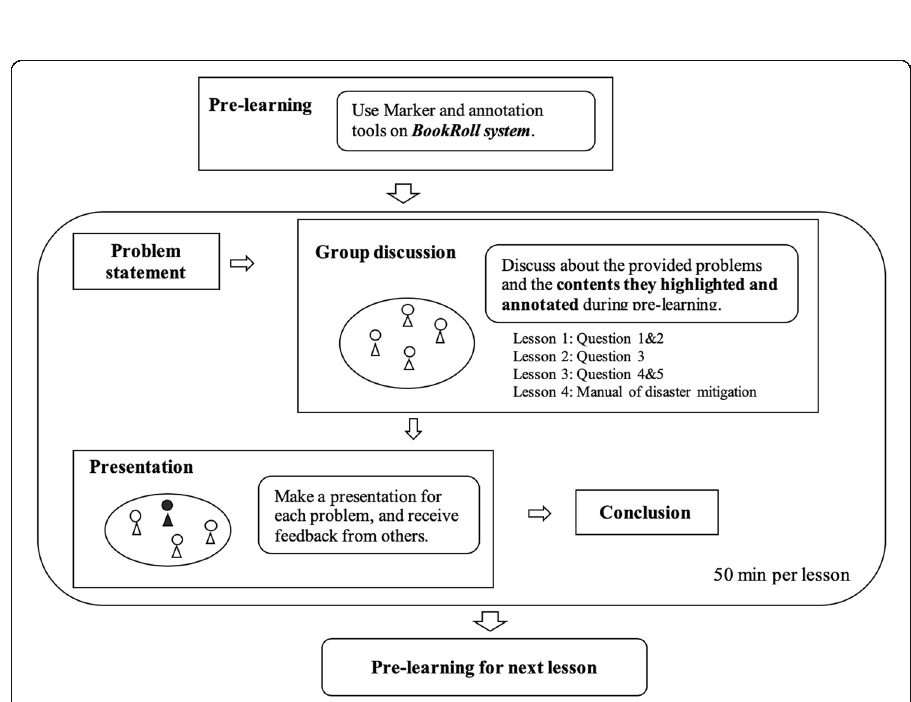
Fig. 2 The process of the lesson Limnic